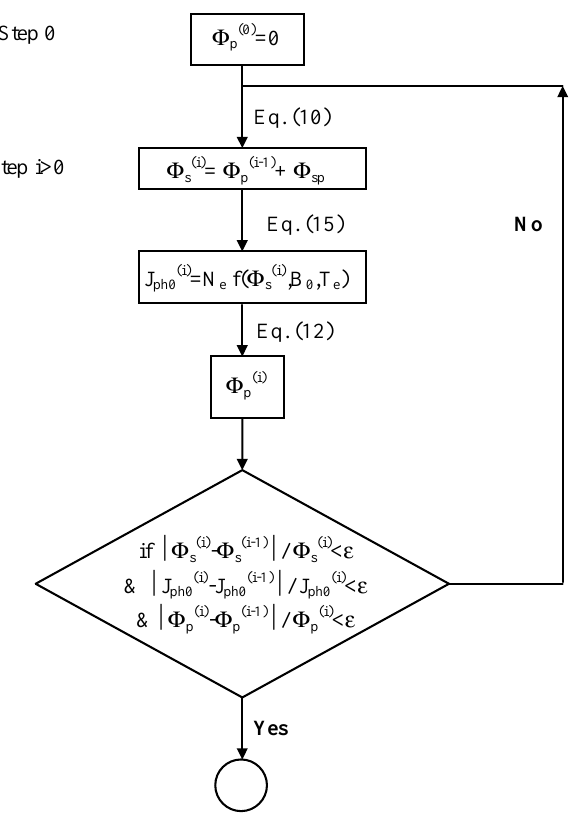
Fig. 10. Flow chart of the procedure used for determining the pho- toemission rate.